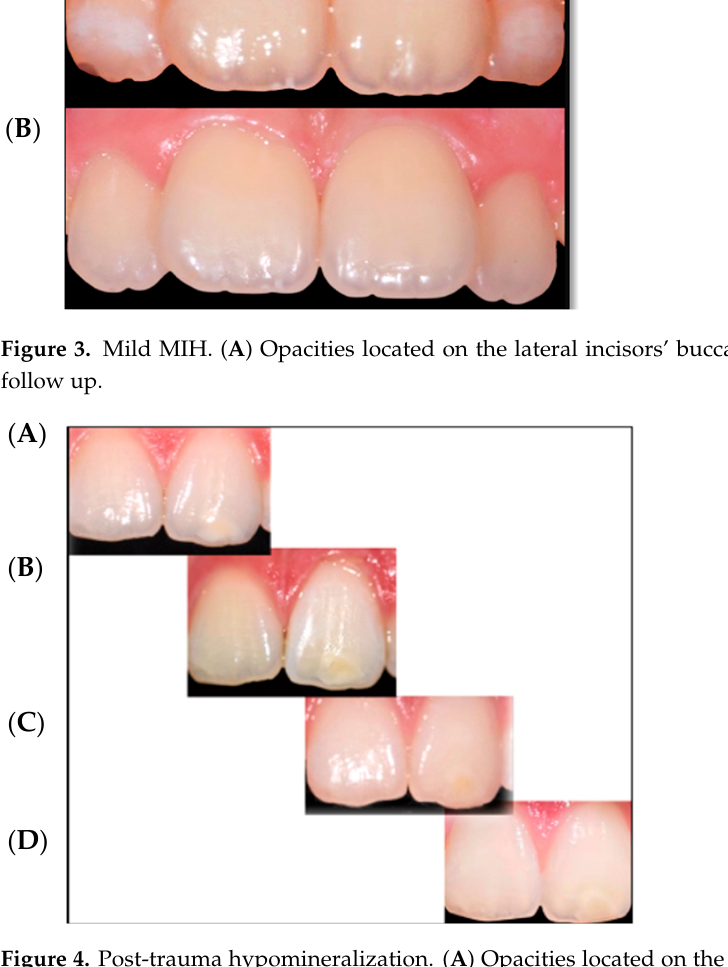
Figure 4. Post-trauma hypomineralization. ( A ) Opacities located on the left central incisor buccal surface. ( B ) Immediately after resin infiltration. ( C ) 12-month follow up. ( D ) 24-month follow up.